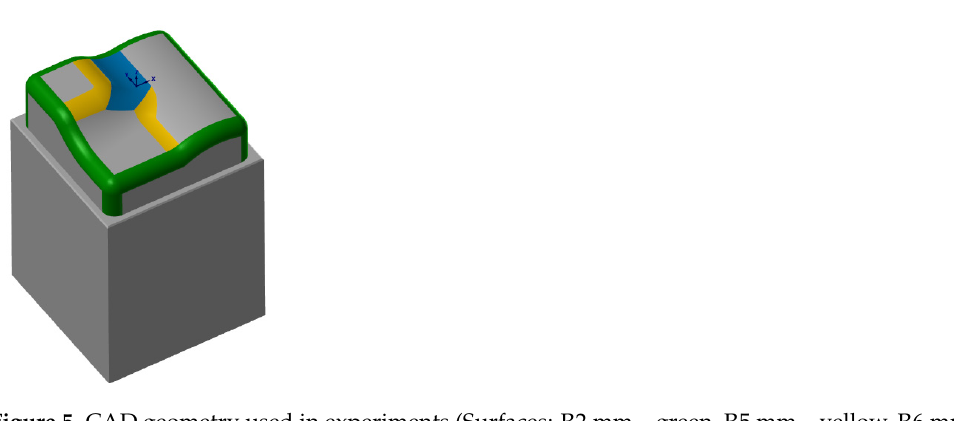
Figure 4. Tool axis inclination angle in both directions ( a ) Tool axis inclination angle in pick feed direction β n ( b ) Tool axis inclination angle in feed direction β f .